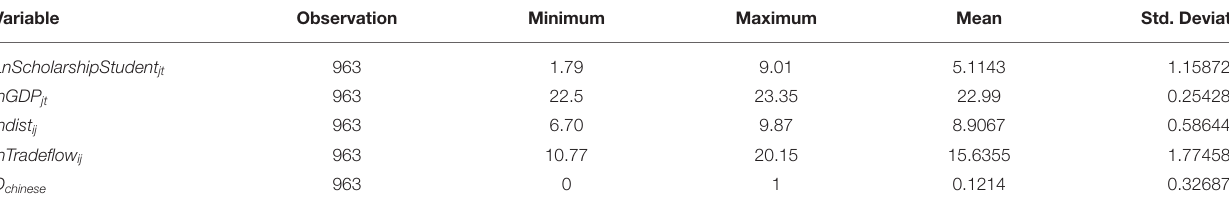
TABLE 4 | Descriptive statistics (including dummy variable).